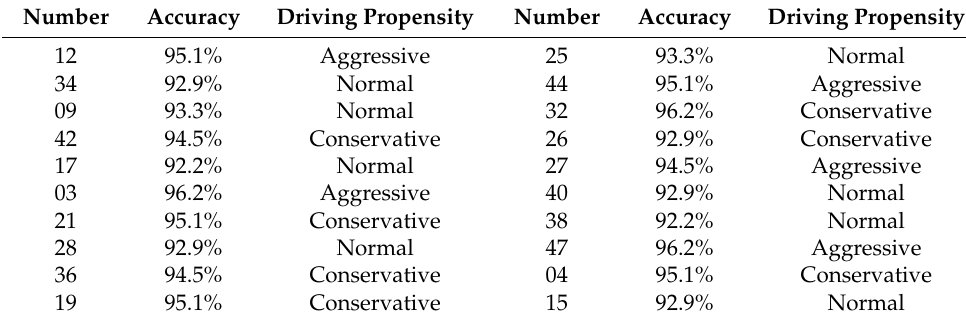
Table 11. The final verification results of 20 drivers in the real vehicle experiment.